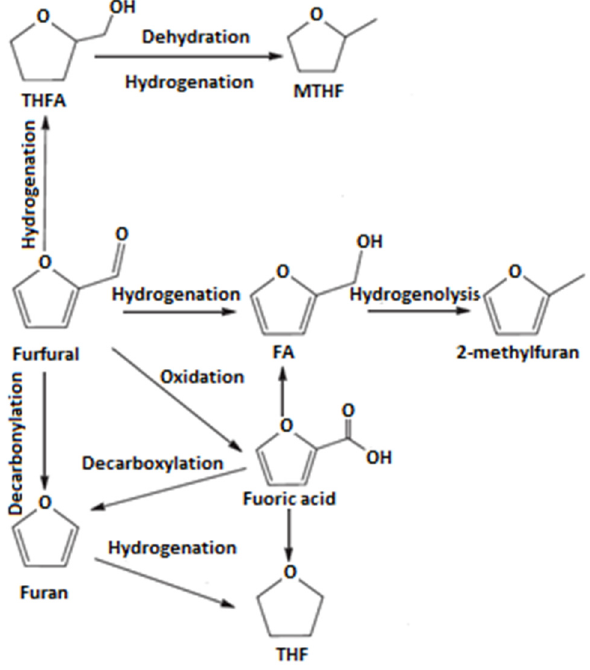
Figure 1. Possible pathways of hydrogenation of furfural based on data from [3].